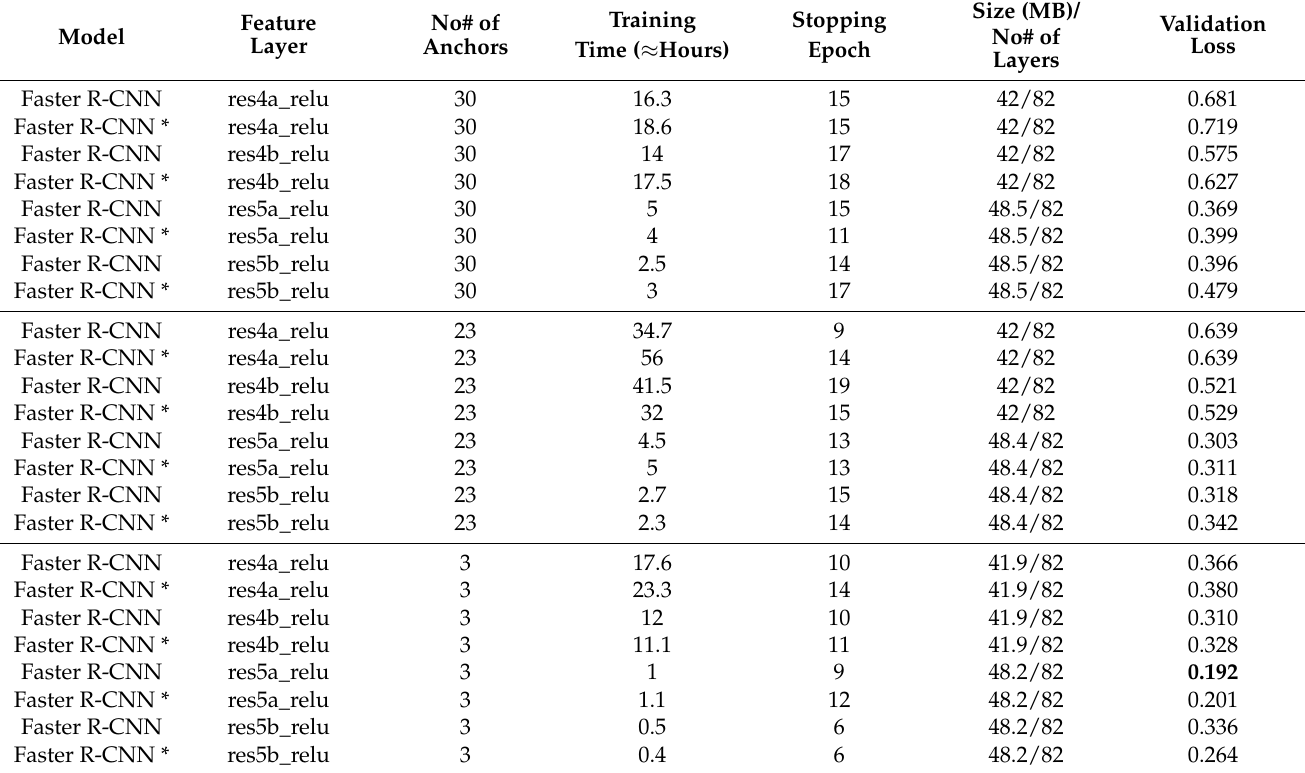
Table 2. Training details (Faster R-CNN with ResNet-18 using mini-batch size of